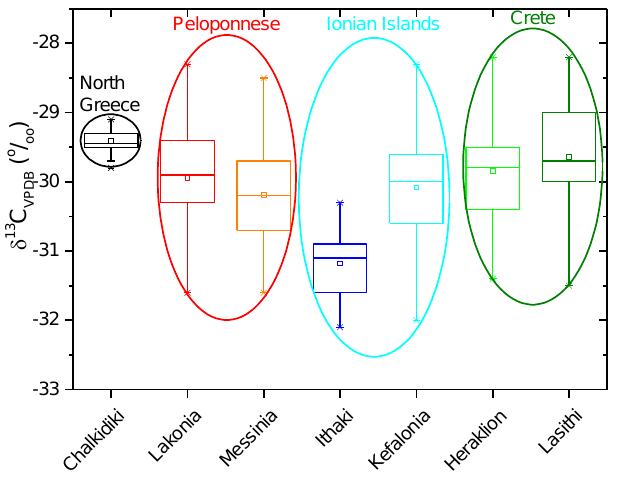
Figure 1. δ 13 C VPDB of olive oils from Greek areas.